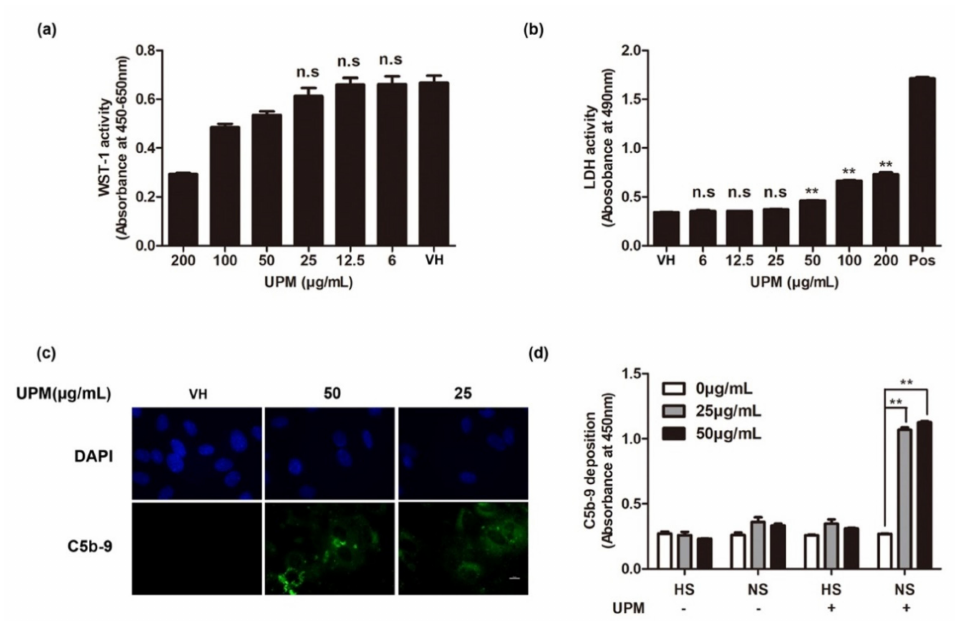
Figure 1. Effects of urban particulate matter (UPM) on human umbilical vein endothelial cell (HUVEC) viability and complement activation. ( a ) The viability of UPM-treated HUVECs. HUVECs were exposed to UPM for 24 h (200 µ g/mL to 0 µ g/mL). Cell viability was analyzed using the WST-1 assay. Data are represented as mean ± standard deviation (SD) of the mean ( n = 5). One-way ANOVA with multiple comparisons. The mean of each column with the mean of the VH column. n.s = not significant. ** p < 0.01. VH: vehicle control (5% methanol). ( b ) Cytotoxicity of UPM in HUVECs. Lactate dehydrogenase (LDH) activities were measured in HUVECs exposed to UPM for 24 h. Data are represented as mean ± SD, n = 5. One-way ANOVA with multiple comparisons. n.s = not significant. ** p < 0.01. ( c ) Detection of C5b-9 depositions on UPM-treated HUVECs by immunofluorescence assay (IFA). HUVECs were treated with UPM for 24 h (0 µ g/mL, 25 µ g/mL, and 50 µ g/mL), followed by treatment with 10% normal human serum (NS) for another 30 min. The C5b-9 deposition was detected by IFA with an anti-C5b-9 antibody. Nuclei were stained with DAPI (blue), C5b-9: deposition of C5b-9 (green). Scale bar: 10 µ m. ( d ) Analysis of C5b-9 depositions by cell-based enzyme-linked immunosorbent assay (ELISA). UPM-exposed HUVECs were treated with heat-inactivated human serum (HS) or NS for 30 min, followed by analysis of C5b-9 depositions using cell-based ELISA. Results are shown as mean ± SD, n = 5, One-way ANOVA with multiple comparisons. ** p <